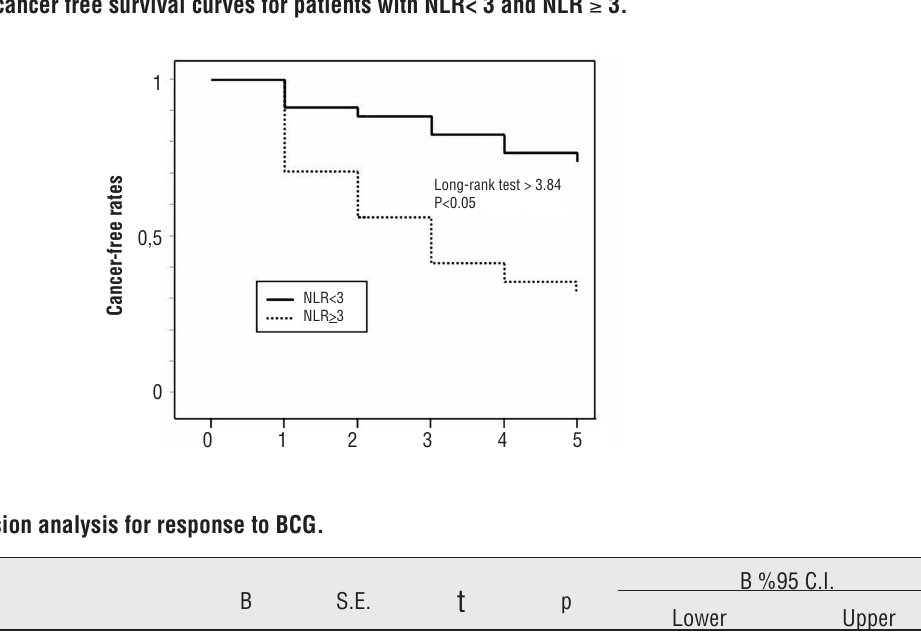
Figure 2 - Kaplan-Meier cancer free survival curves for patients with NLR< 3 and NLR ≥ 3.